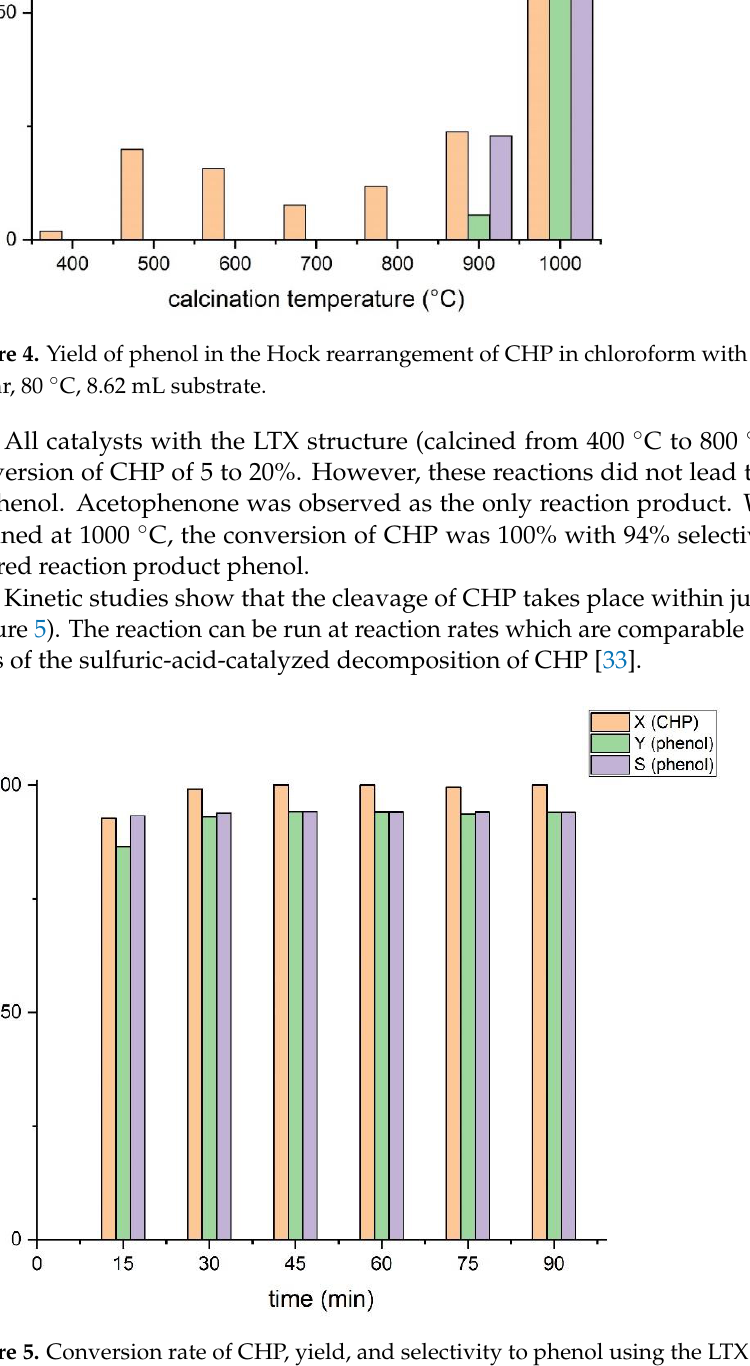
Figure 5. Conversion rate of CHP, yield, and selectivity to phenol using the LTX zeolite calcined at 1000 °C over time; 8.62 mL substrate in 50 mL chloroform, 1 g catalyst, 45 bar, 80 °C, 300 rpm in 75 mL autoclaves.